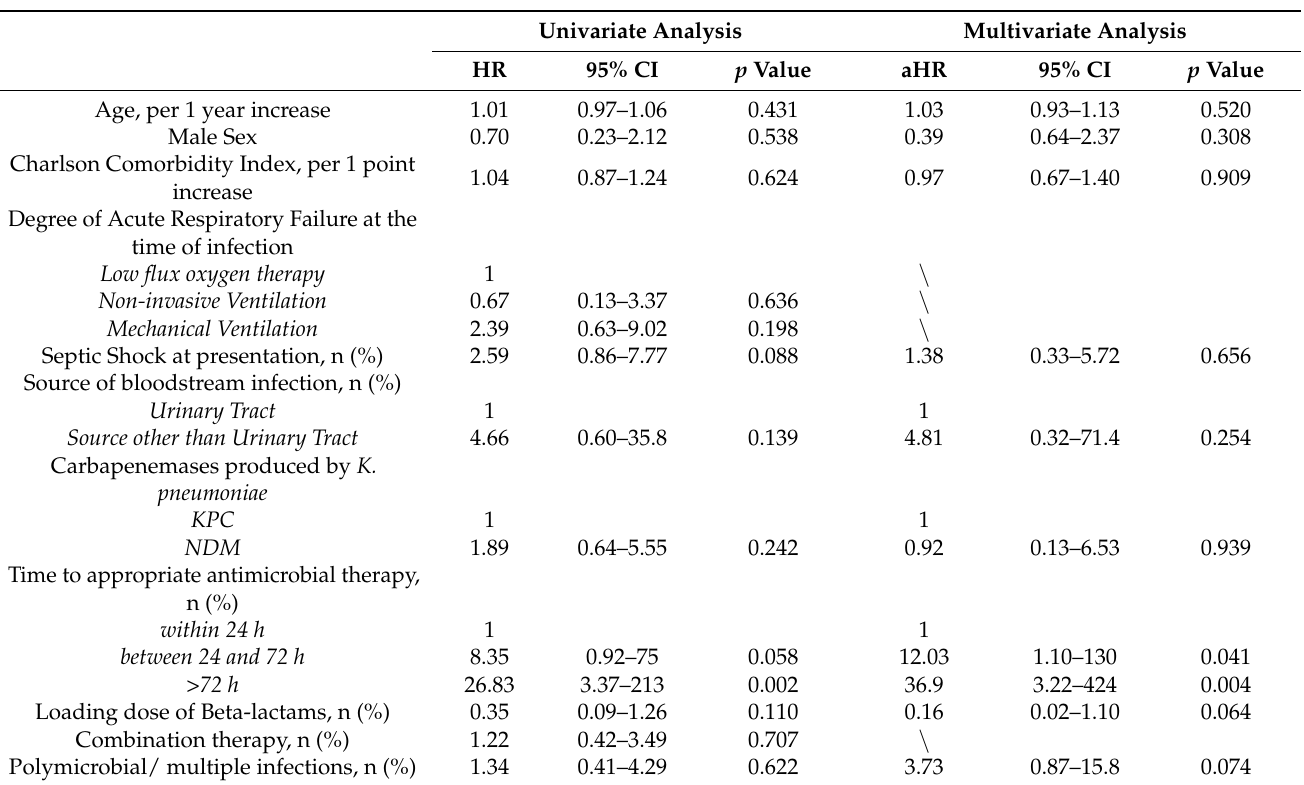
Table 4. Cox regression model for the risk of 14-day mortality. Univariate Analysis Multivariate